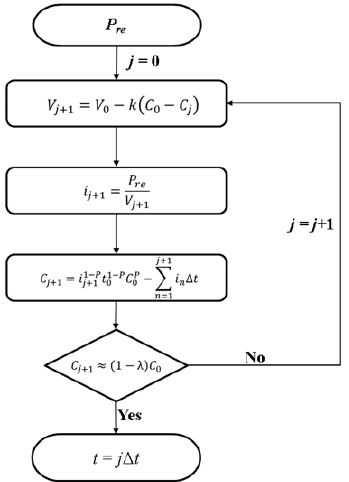
Figure 3. Iteration process to estimate endurance from required power with consideration of battery discharge.